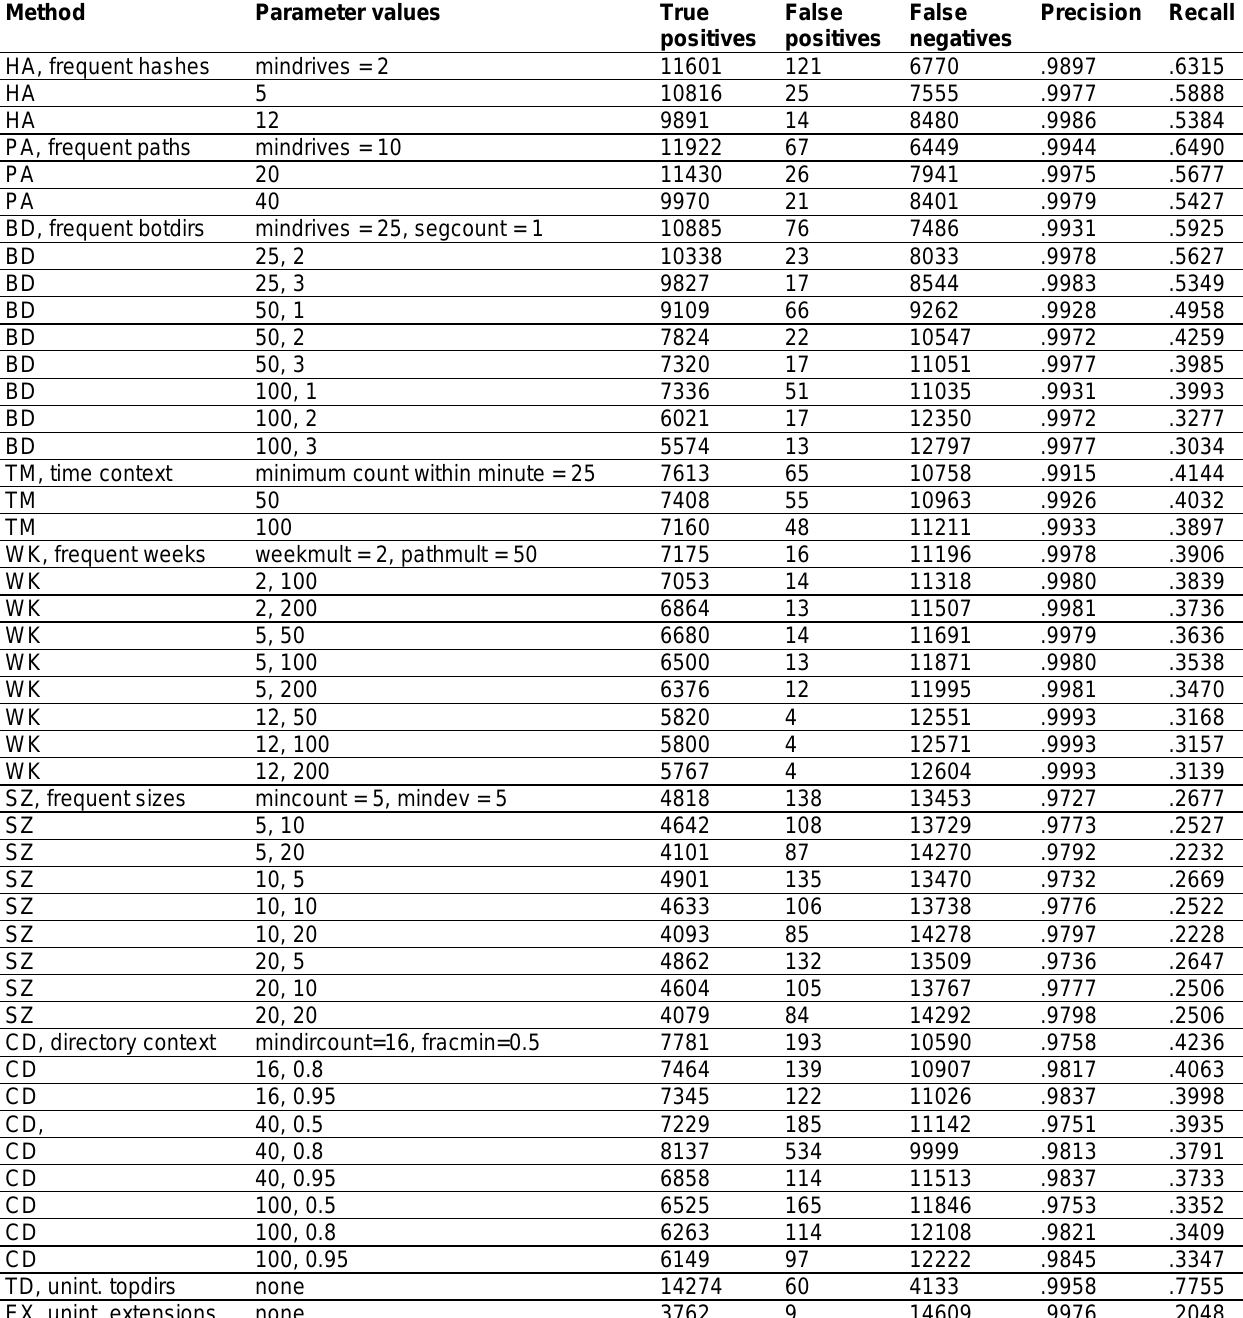
Table 5. Effects of parameter variation on performance of different methods of identifying uninteresting